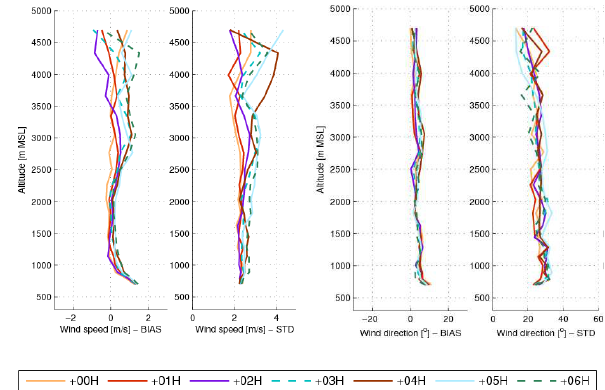
Fig. 2. Data availability versus altitude range of the independent wind profiler mobile unit during the two validation observation pe- riods in Kleindoettingen 2008 (left panel) and Muehleberg 2009 (right panel) for the high resolution mode (blue line) and low res- olution mode (red line). The total amount of data sample for each campaign was over 10000.